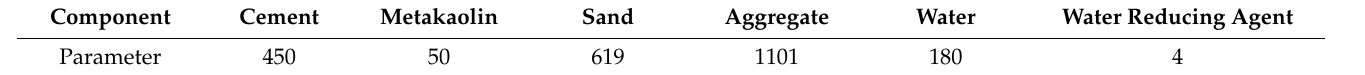
Table 2. Metakaolin (MK) Concrete Proportion Design (Kg/m³).